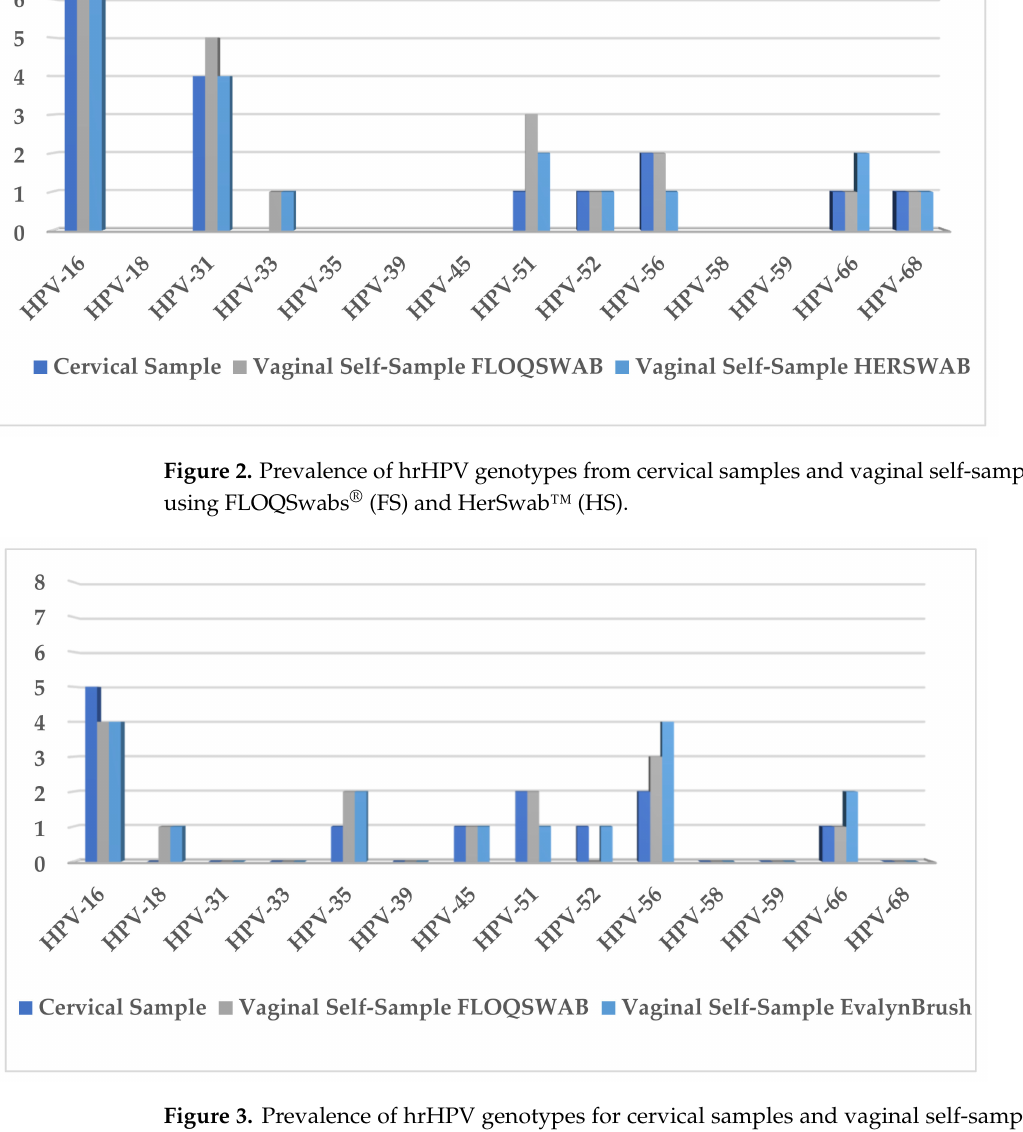
Figure 3. Prevalence of hrHPV genotypes for cervical samples and vaginal self-samples collected using FLOQSwabs ® (FS) and Evalyn ® Brush